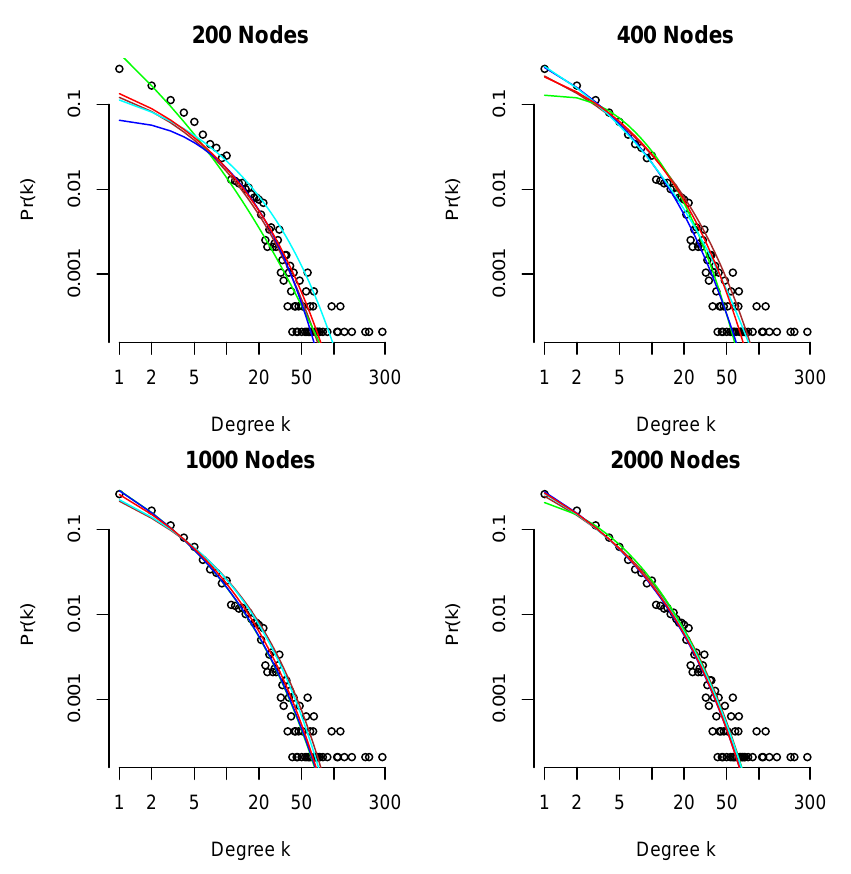
Figure 1: Empirical degree distribution of present yeast PIN dataset (black circles) and MMI estimates for the degree distribution resulting from five independent (shown in black, blue, red, green, cyan) subnets generated by sampling sets of 200, 400, 1000 and 2000 nodes, respectively (continuous